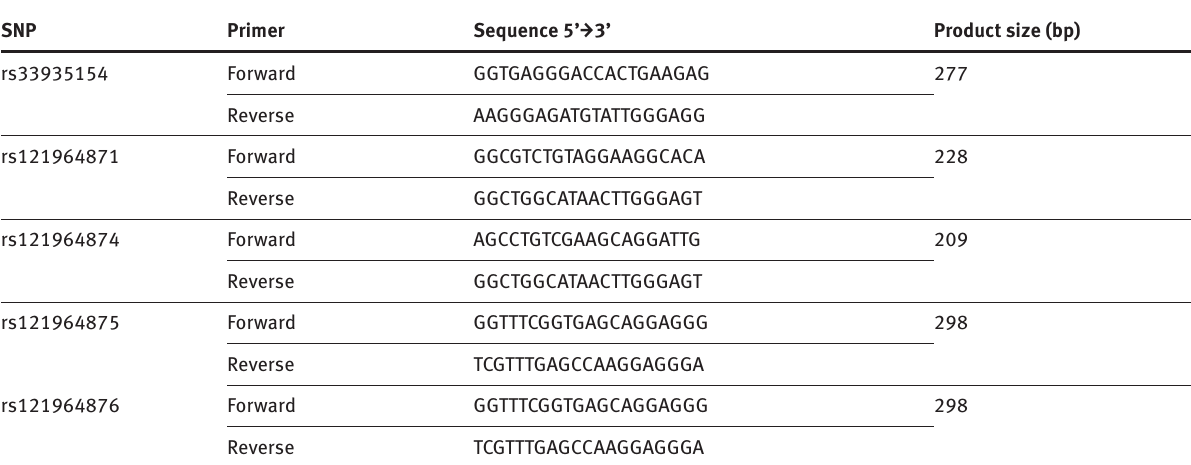
Table 1: Primer sequence of 5 SNPs in CDH1 gene used for PCR.